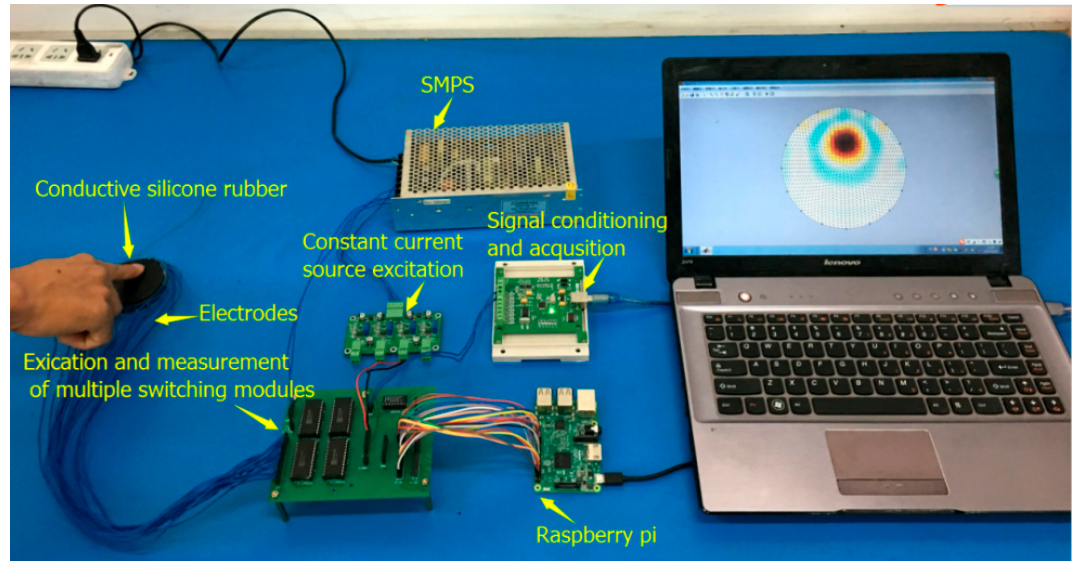
Figure 6. Experimental device of pressure distribution imaging system.